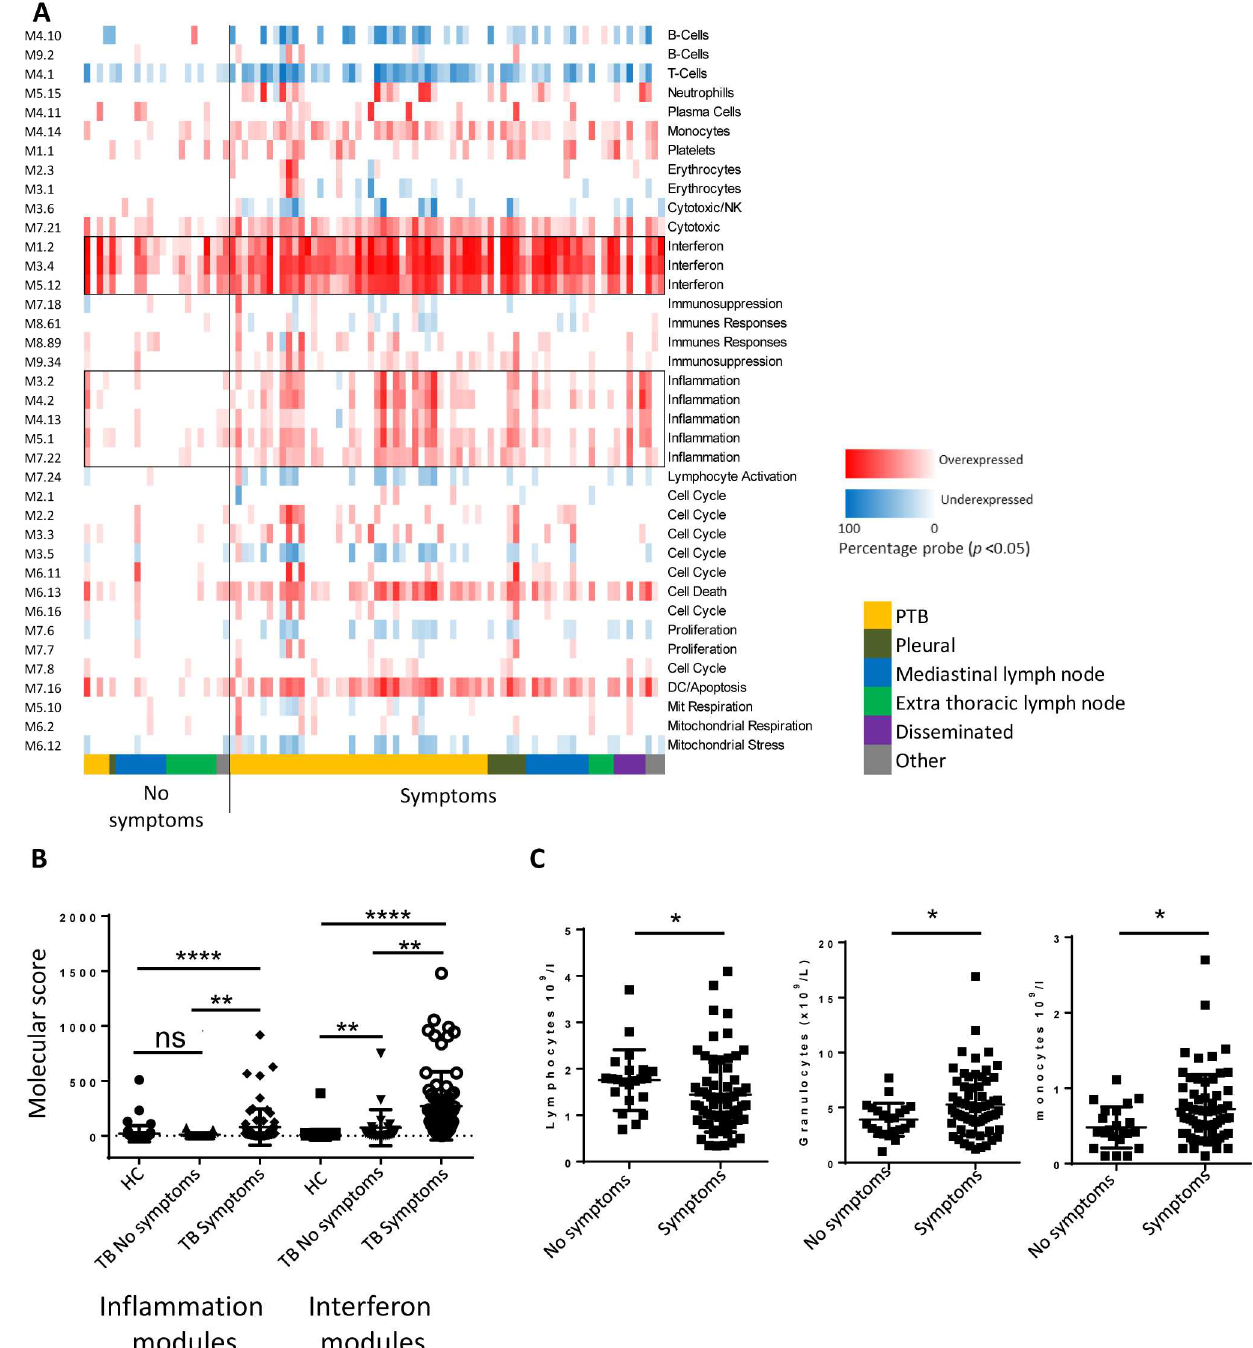
Fig 4. Symptom status linked to alteration in modular profile and blood counts. (A) Individualmodular analysis for all TB patients groupedby symptom status and site of disease, boxed are modules annotatedas interferon or inflammation. 38 annotatedmodules are displayedas a heatmap with red indicatessignificant over-abundance of transcripts and a blue indicating significant under-abundance (p < 0.05). The colour intensity represents the percentageof genes in that module that are significantly differentially expressed. (B) MDTH calculated for all interferon moduletranscripts and all inflammatory module transcripts (healthy controls used as control group). TB patients groupedaccordingto symptom status (median value, error bars SD) statistical testing Kruskal Wallis with Dunn’s multiple testing correction. (C) TB patients groupedaccordingto symptom status with lymphocyte, granulocyte and monocytes counts shown (median value, error bars SD) statistical testing Mann-Whitney U.